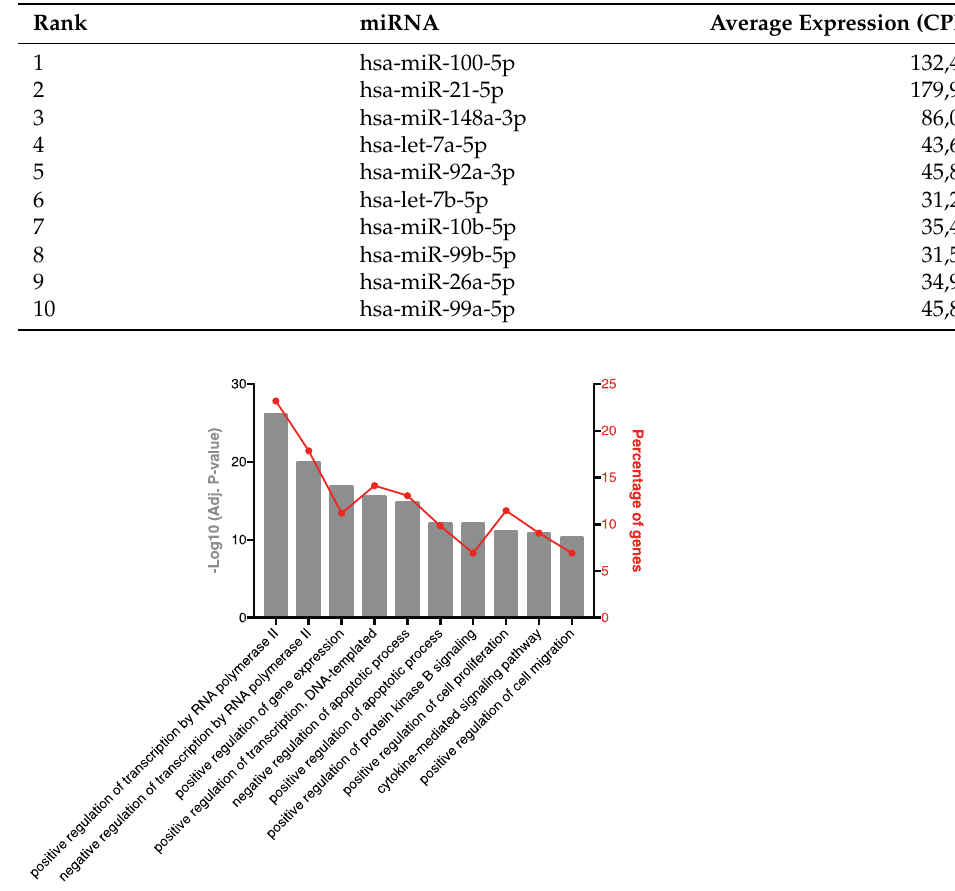
Figure 2. Biological processes associated with experimentally validated targets of highly ranked SF EV miRNA. Pathway analysis was performed on experimentally validated gene targets of the 10 highest-ranked miRNAs. The percentage of target genes associated with each biological process are indicated.